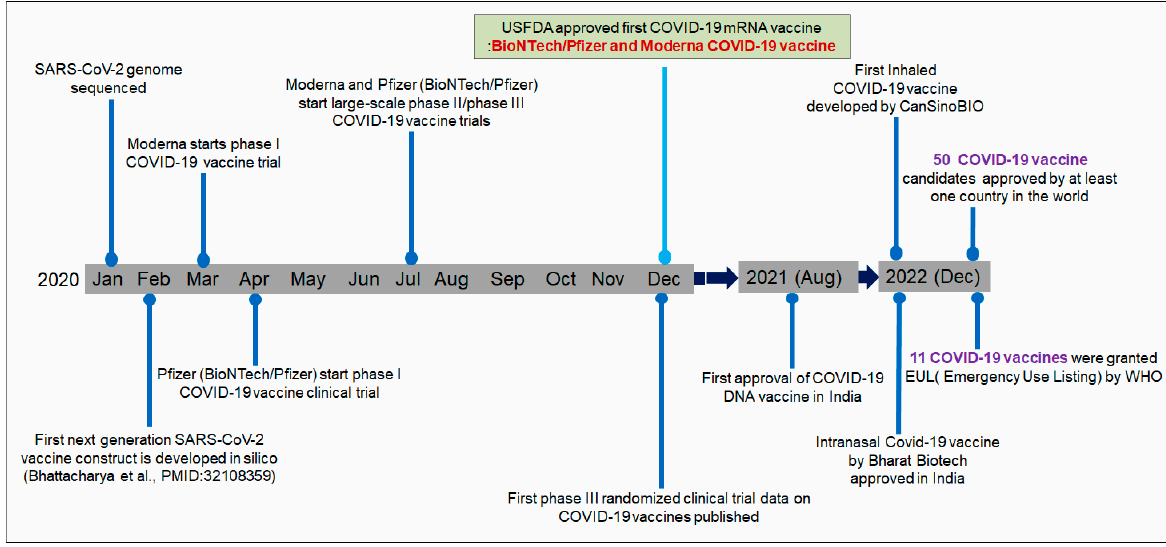
Figure 1. The timeline describes the different milestone achievements of vaccine development. Similarly, till today, 11 COVID-19 vaccines have been granted an Emergency Use Listing (EUL) by the WHO [30]. Several vaccine candidates have been developed that